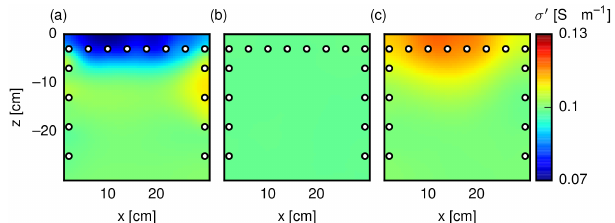
Figure 3. EIT inversion results (real component of complex conduc- tivity) obtained from synthetic data using a modeling grid in the in- version with a (a) 1.5cm lower, (b) identical, and (c) 1.5cm higher position of the top boundary compared to the grid (forward model) used to compute synthetic measurments. The forward model was homogeneously parameterized with a conductivity distribution of 0.1Sm − 1 . Only the upper part of the modeling domain (rhizotron) is shown. Electrode positions and measurement configurations are the same for all three cases.